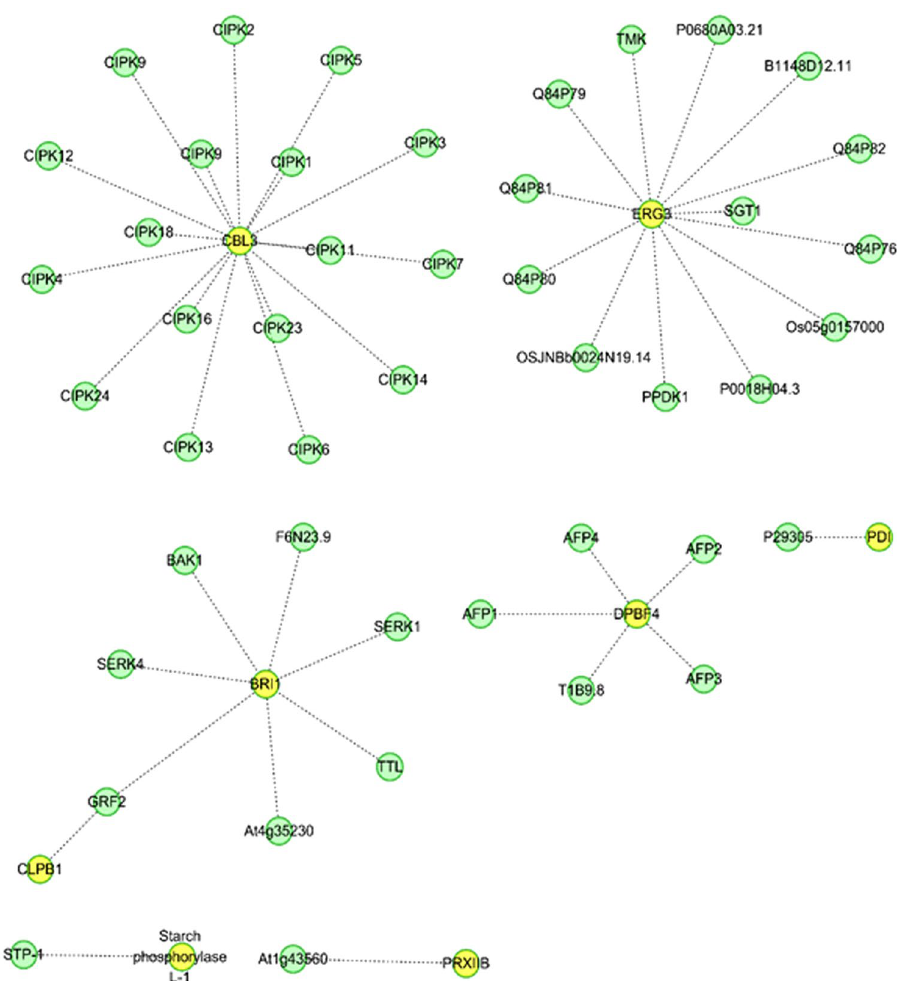
Figure 3. Interaction networks of the differentially expressed proteins in wheat cultivar Jing411. Yellow nodes denote differentially expressed proteins, whereas green nodes denote proteins interacting directly with the differentially expressed proteins. Calcineurin B-like 3 (CBL3), C-5 sterol desaturase (ERG3), Brassinosteroid receptor 1 (BRI1), DPBF4, Protein disulfide isomerase (PDI), Chaperone protein (CLPB1), starch phosphorylase L-1, and Peroxiredoxin B